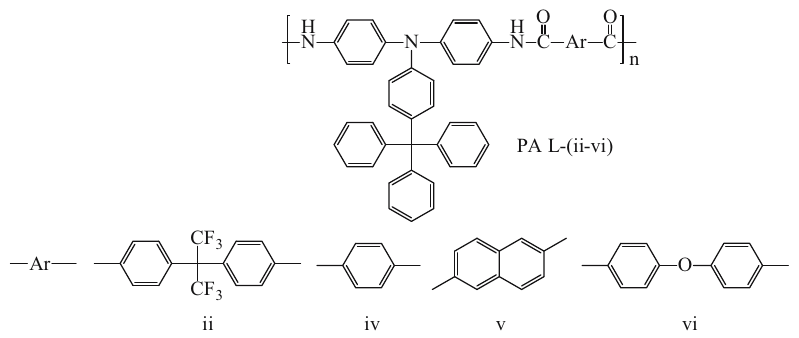
Figure 15: Structure of the PAs having TPA containing pendant trityl moiety ( 94 ) .